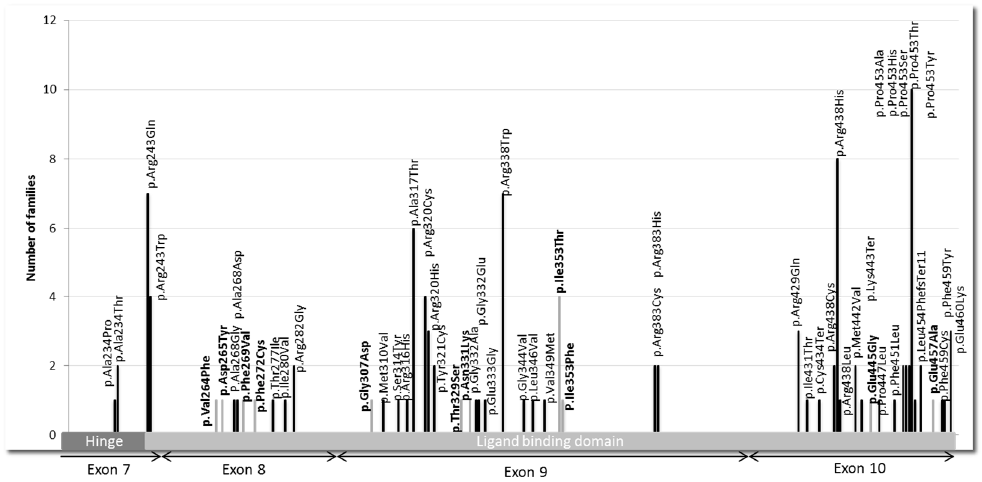
Figure 2. Location of 56 variants in the THRB gene and number of families for each variant. The x -axis indicates the consecutive amino acid numbers, exon, and functional domains of THRB gene. The y -axis indicates the numbers of families. Plain bars represent known variants, while grey bars represent variants with unknown significance.